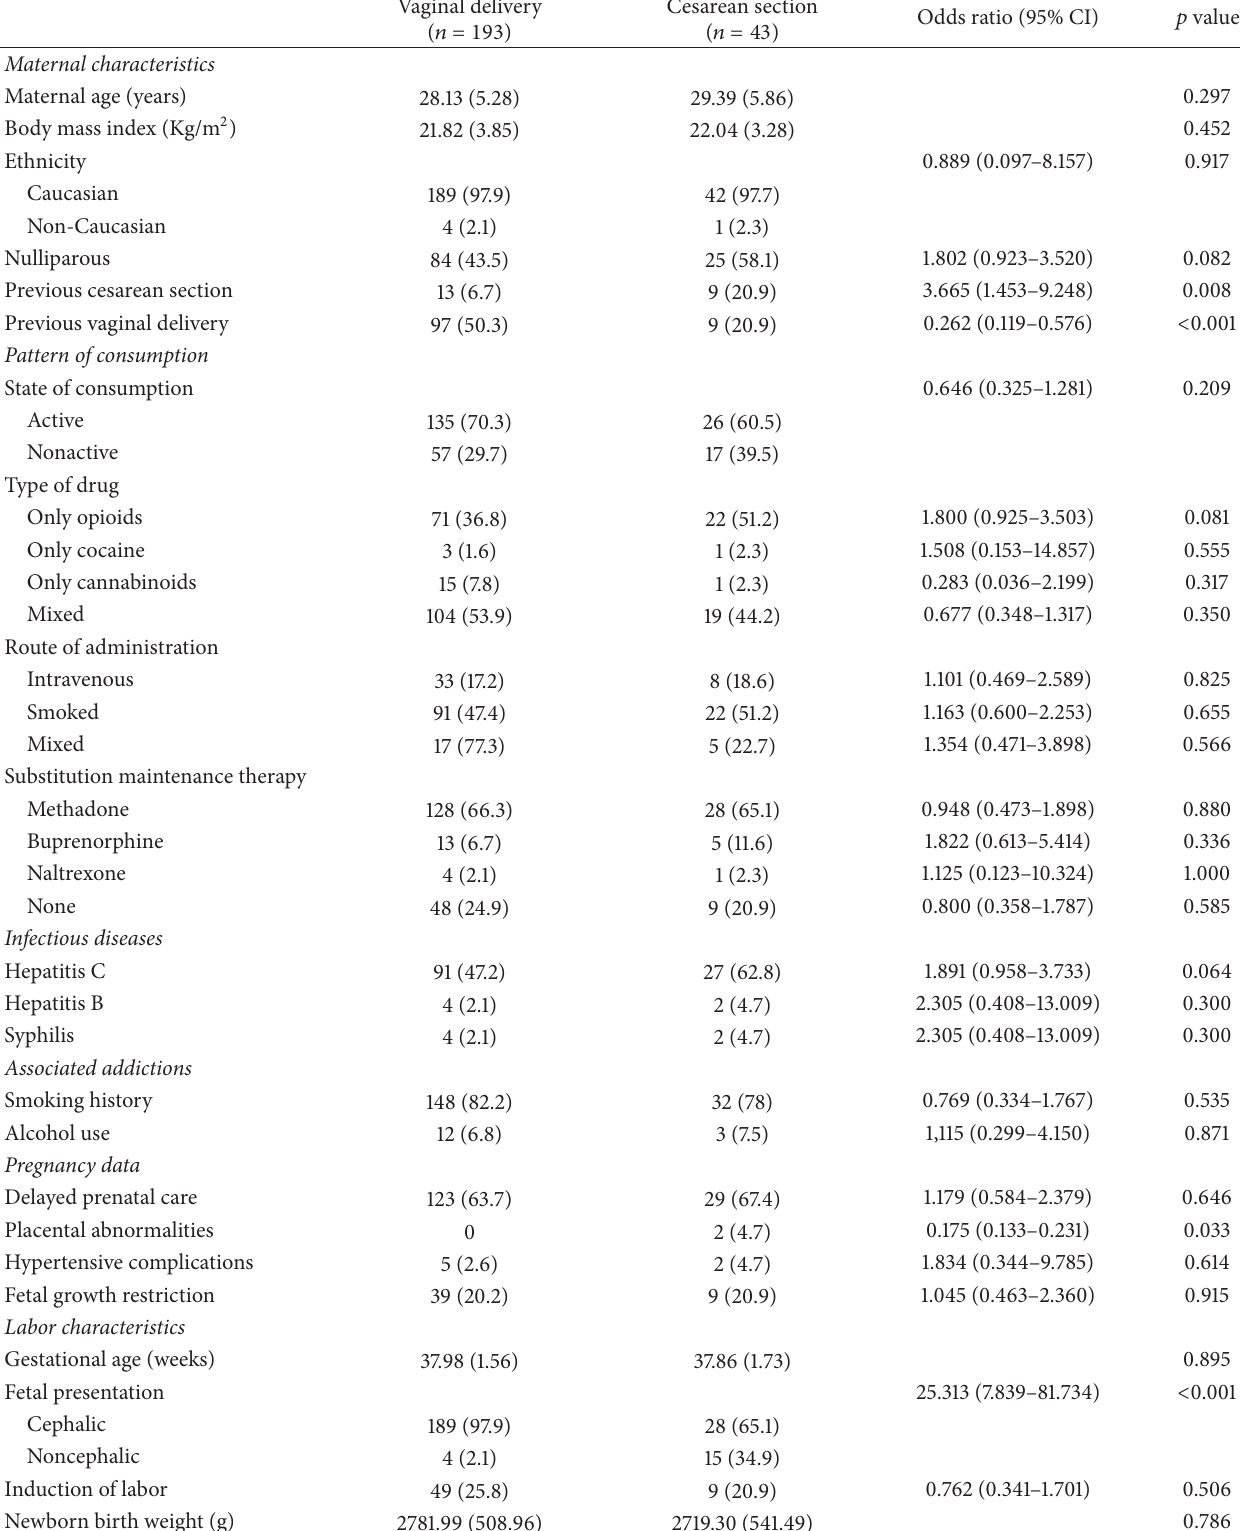
Table 4: Factors that influence the mode of delivery in drug-dependent